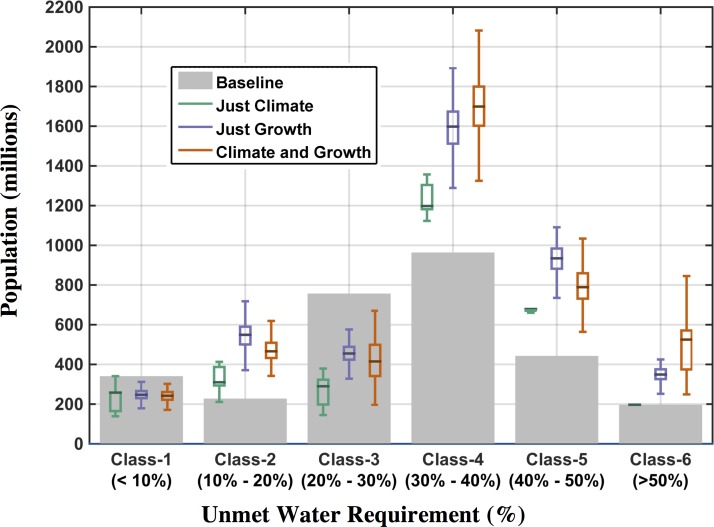
Population exposed to water stress based on UWR classifications using the 2041–2050 mean.Grey bars represent the number of people in each class in the baseline scenario (set to year-2000 value); the box-and-whisker plots show the distributional characteristics of the three ensemble scenarios.